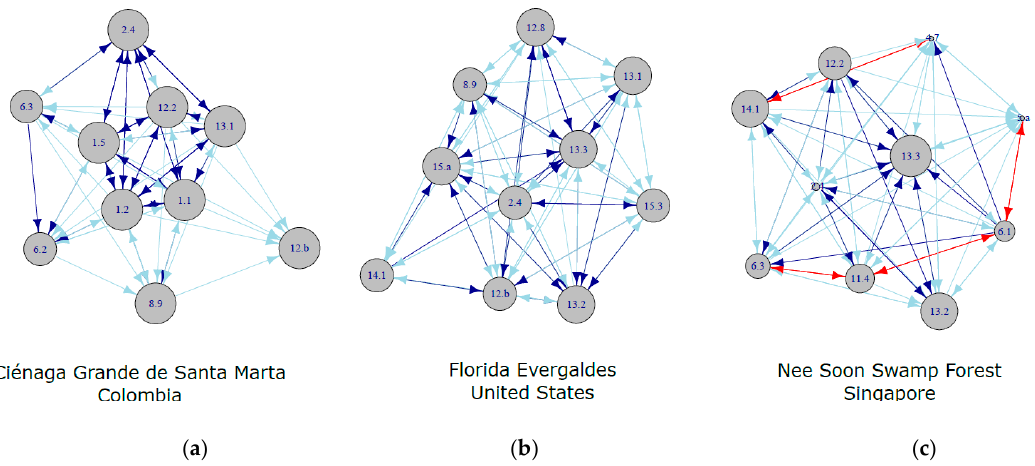
Figure 2. Networks of Sustainable Development Goal (SDG) targets in: ( a ) The Ciénaga Grande de Santa Marta, Colombia, ( b ) the Florida Everglades, United States and ( c ) the Nee Soon Swamp Forest, Singapore. Nodes represent the SDG targets and the bidirectional interlinkages between targets are reinforcing (dark blue), enabling (light blue), constraining (orange), counteracting (red), and consistent (not shown as they imply no relation). Node labels refer to the SDG targets and size of the nodes to the number of targets that are dependent on that specific node (target).